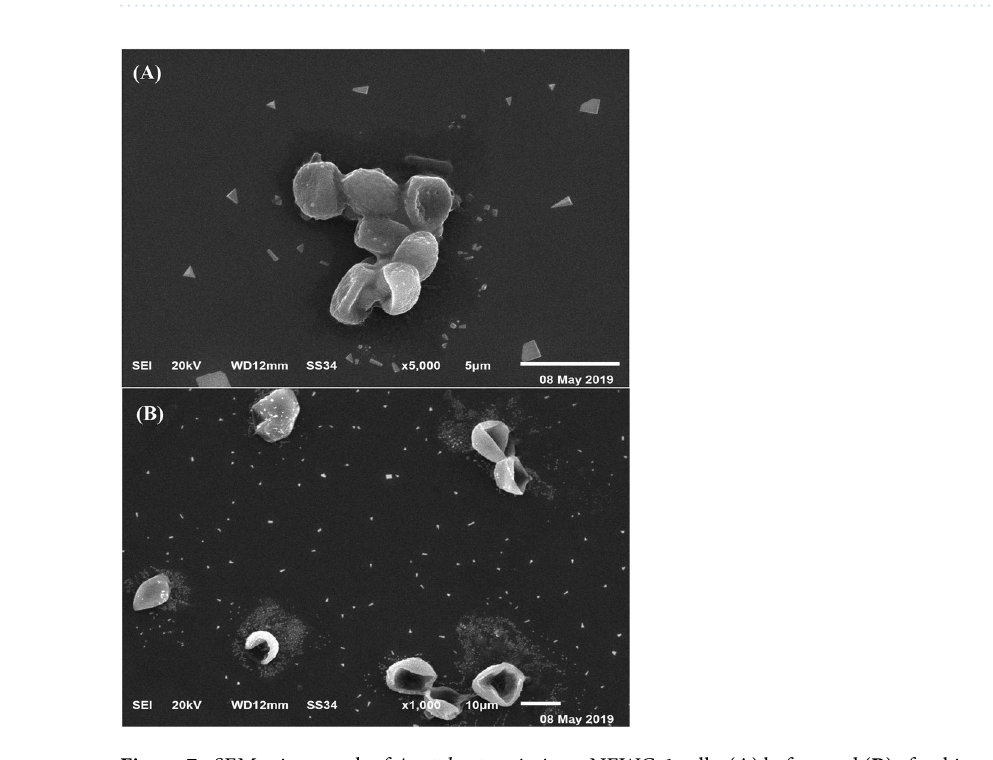
Figure 6. FTIR analysis of Azotobacter nigricans NEWG-1 cells: ( A ) before and ( B ) after biosorption of Cu 2 + ions from aqueous solution.